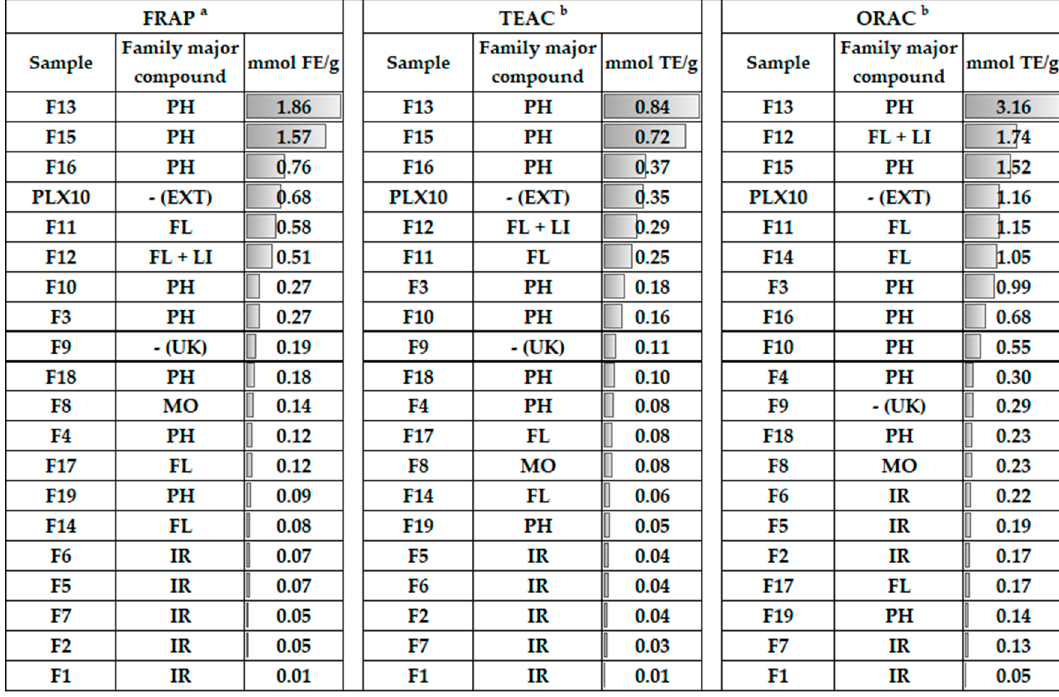
Figure 4. In vitro antioxidant activity estimated through ferric ion reducing antioxidant power (FRAP), trolox equivalent antioxidant capacity (TEAC), and oxygen radical absorbance capacity (ORAC) assays for the lemon verbena extract (PLX ® 10) and its collected fractions. Samples were indicated in decreasing order of activity for each assessed method including gradient data bars as graphical representation. a mmoles equivalents of Fe 2+/ g (dry weight), b mmoles equivalents de Trolox/g (dry weight), EXT: extract, FL: flavonoid, IR: iridoid, LI: lignan, MO: monoterpenoid, PH: phenylpropanoid, UK: unknown.